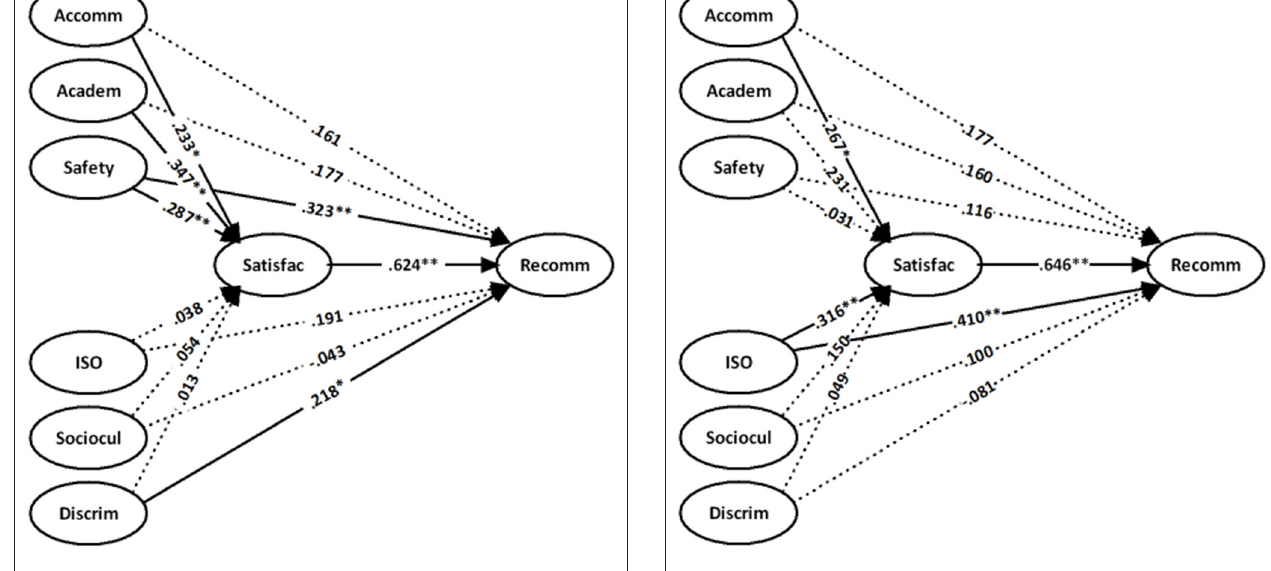
FIGURE 2 | Results for the African (country code = 1) sample with controls for gender and education.